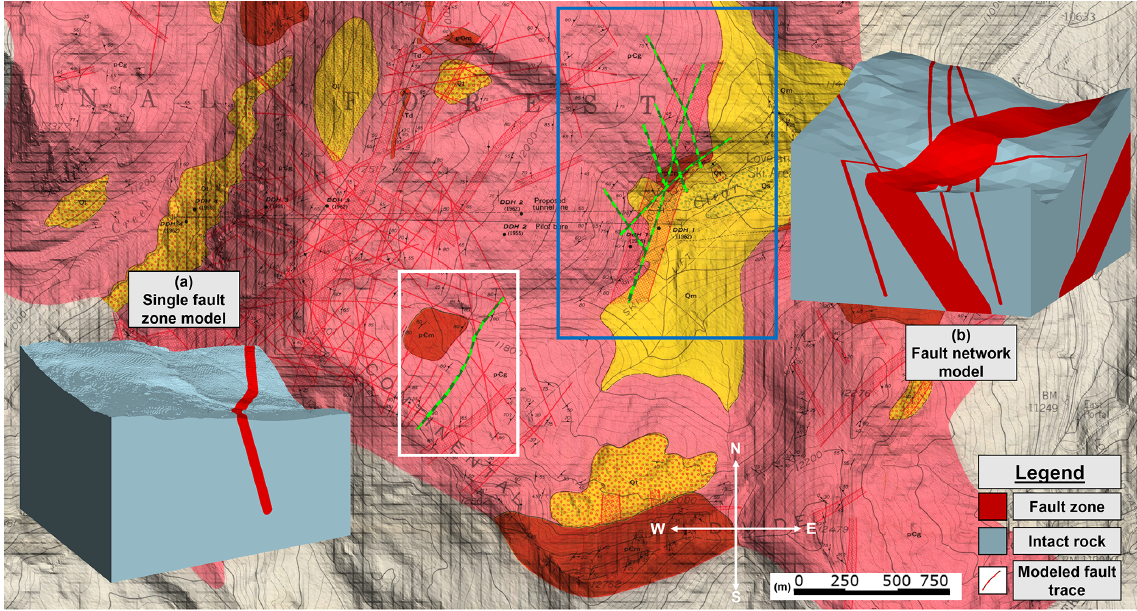
Figure 4. 1:12000 geologic map from Robinson et al. (1974) showing mapped fault zones of varying widths. The white rectangle and associated overlay (a) show the single-fault model, while the blue rectangle and associated overlay (b) show the fault network model. Fault trace(s) used for modeling are highlighted within each rectangle as green